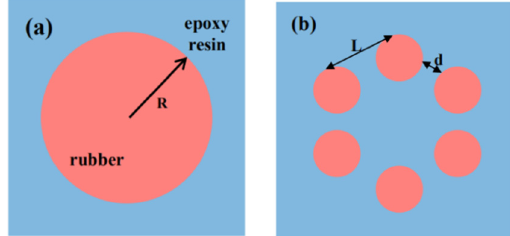
Figure 1. ( a ) Primitive structure; ( b ) graphene structure.